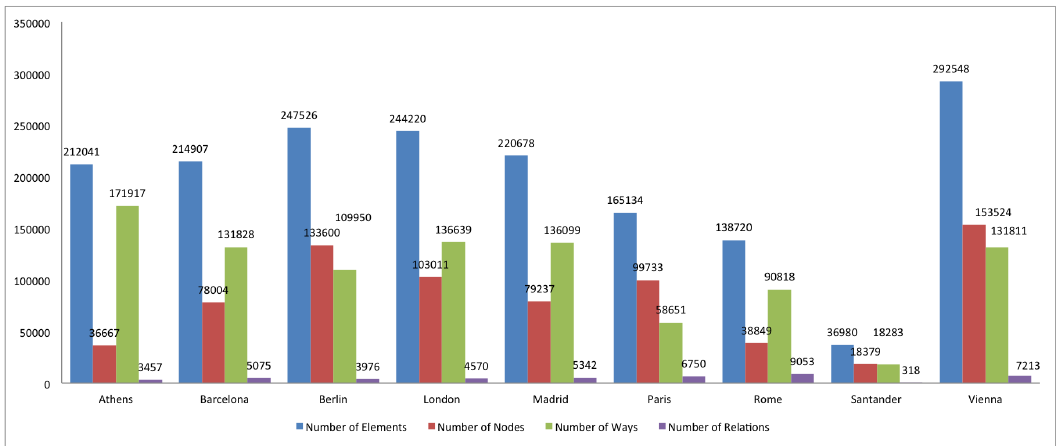
Figure 16. Summary of items, nodes, ways and relations in the European cities under